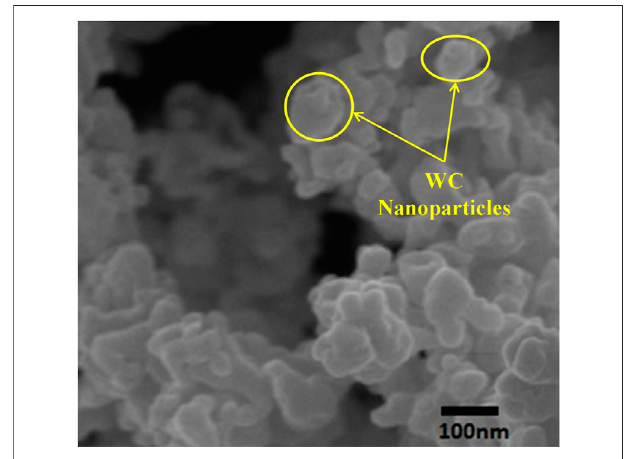
FIGURE 1 | SEM micrograph of WC